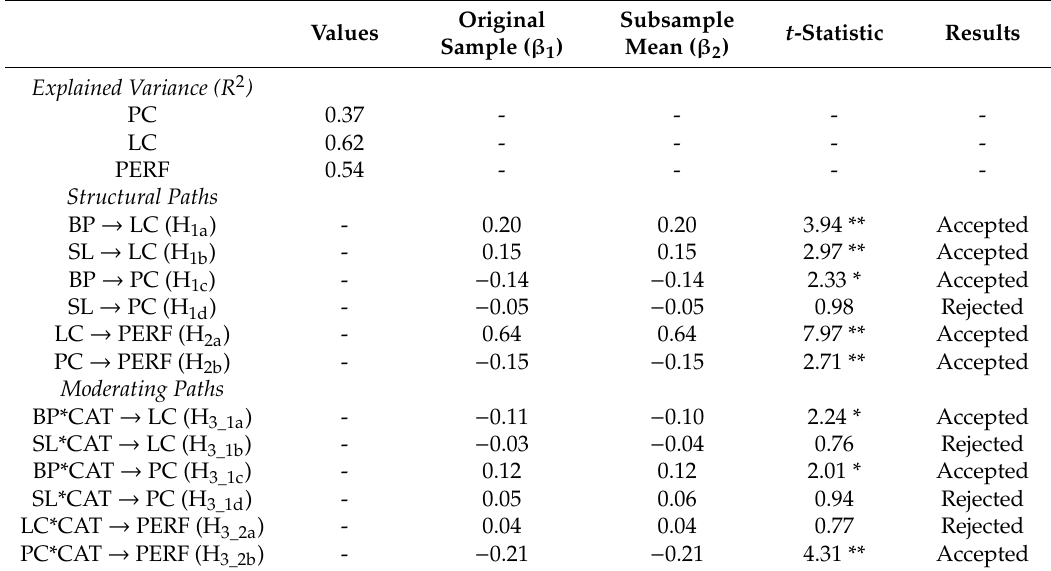
Table 4. Results of path model analysis.